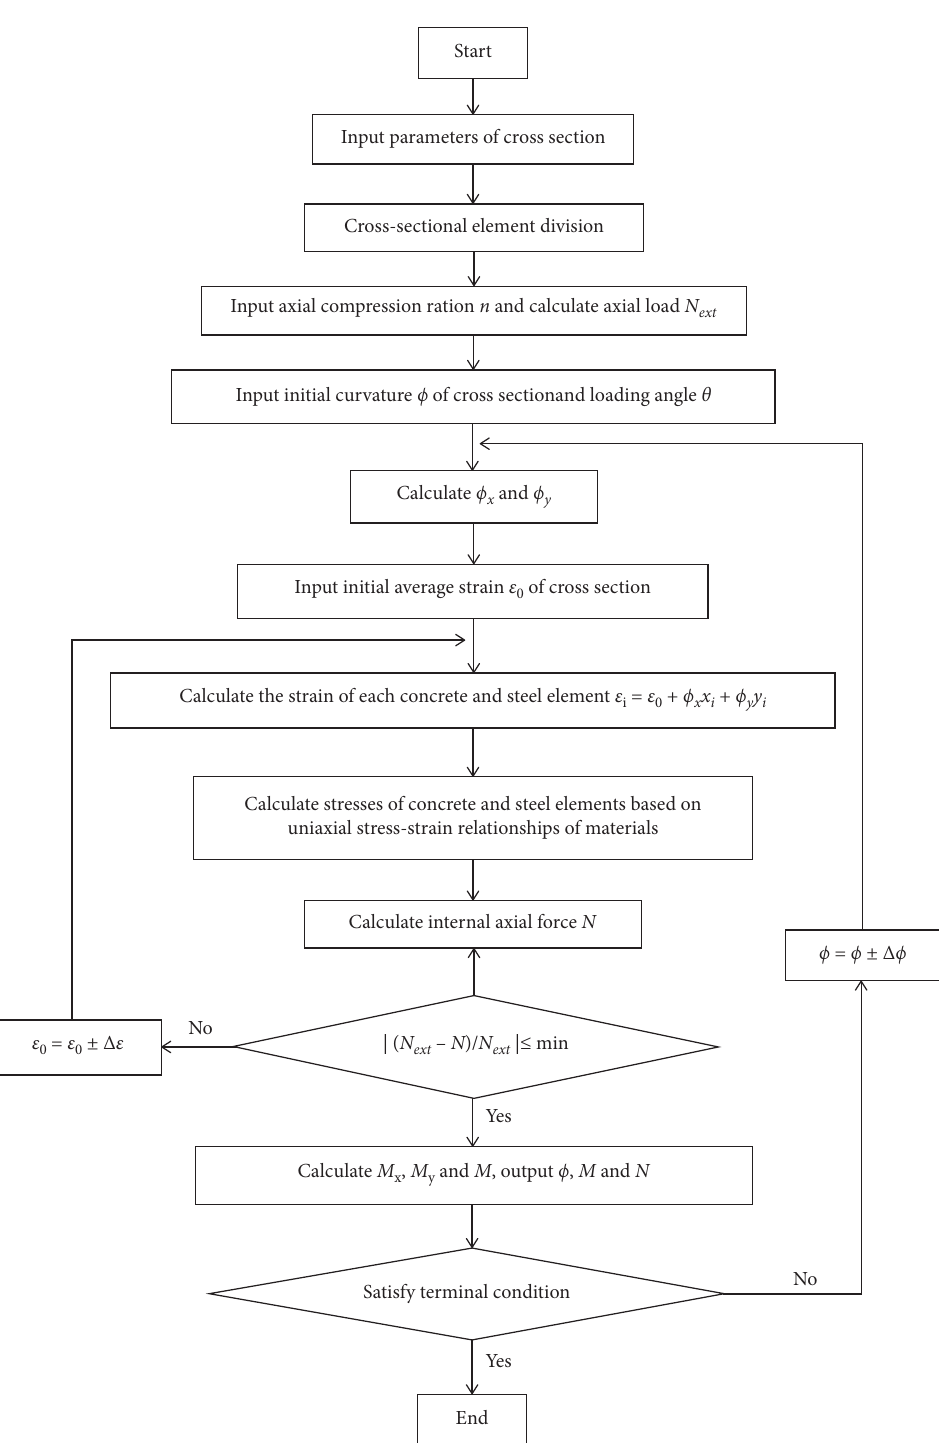
Figure 3: Flow chart of numerical program of T-shaped CFST